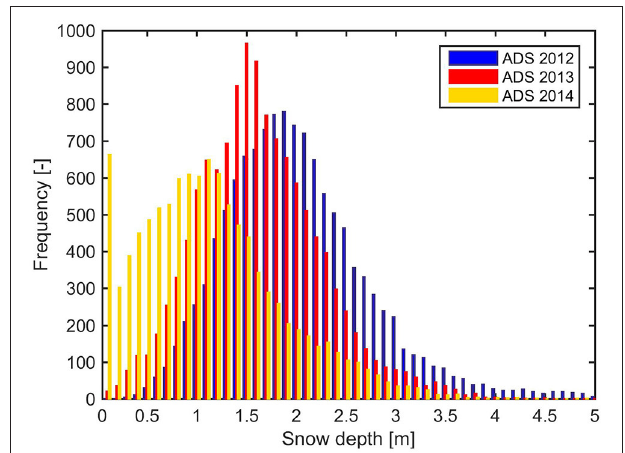
FIGURE 6 | Frequencies of snow depths for all ADS datasets. The blue bars represents the ADS 2012, the red bars the ADS 2013 and the yellow bars the ADS 2014 dataset. Bin sizes of the histogram is 10cm. X-axis is cut at 5m to increase